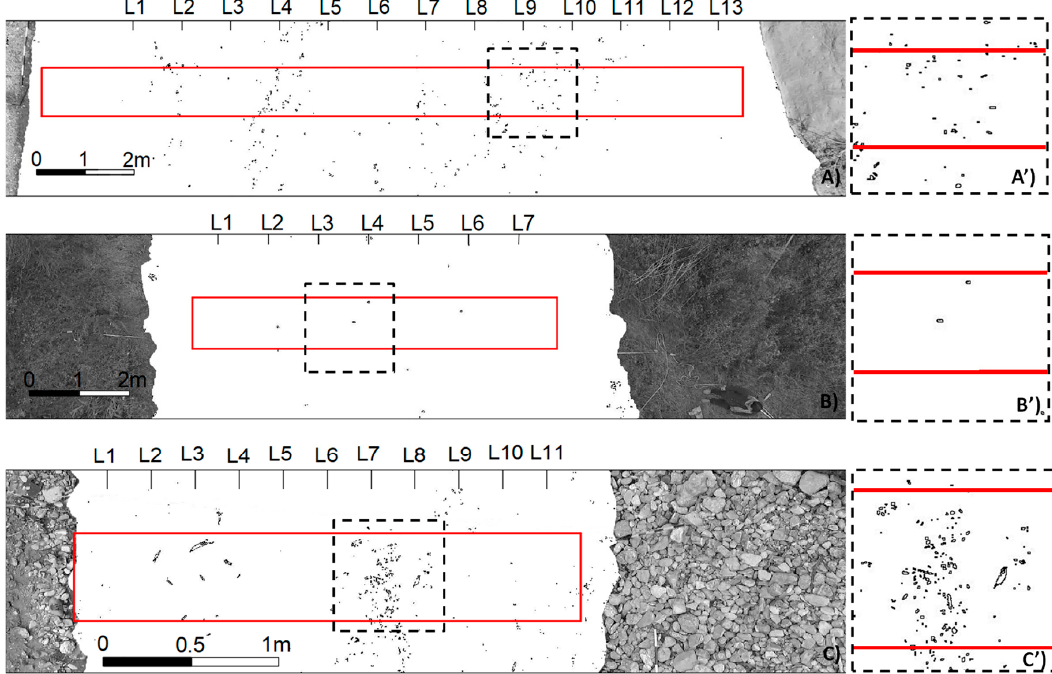
Figure 4. Identification of features on ( A ) Noce, ( B ) Bradano and ( C ) Basento Rivers. Examples of detected features inside ROIs (red squares) are zoomed in (A’, B’, and C’).